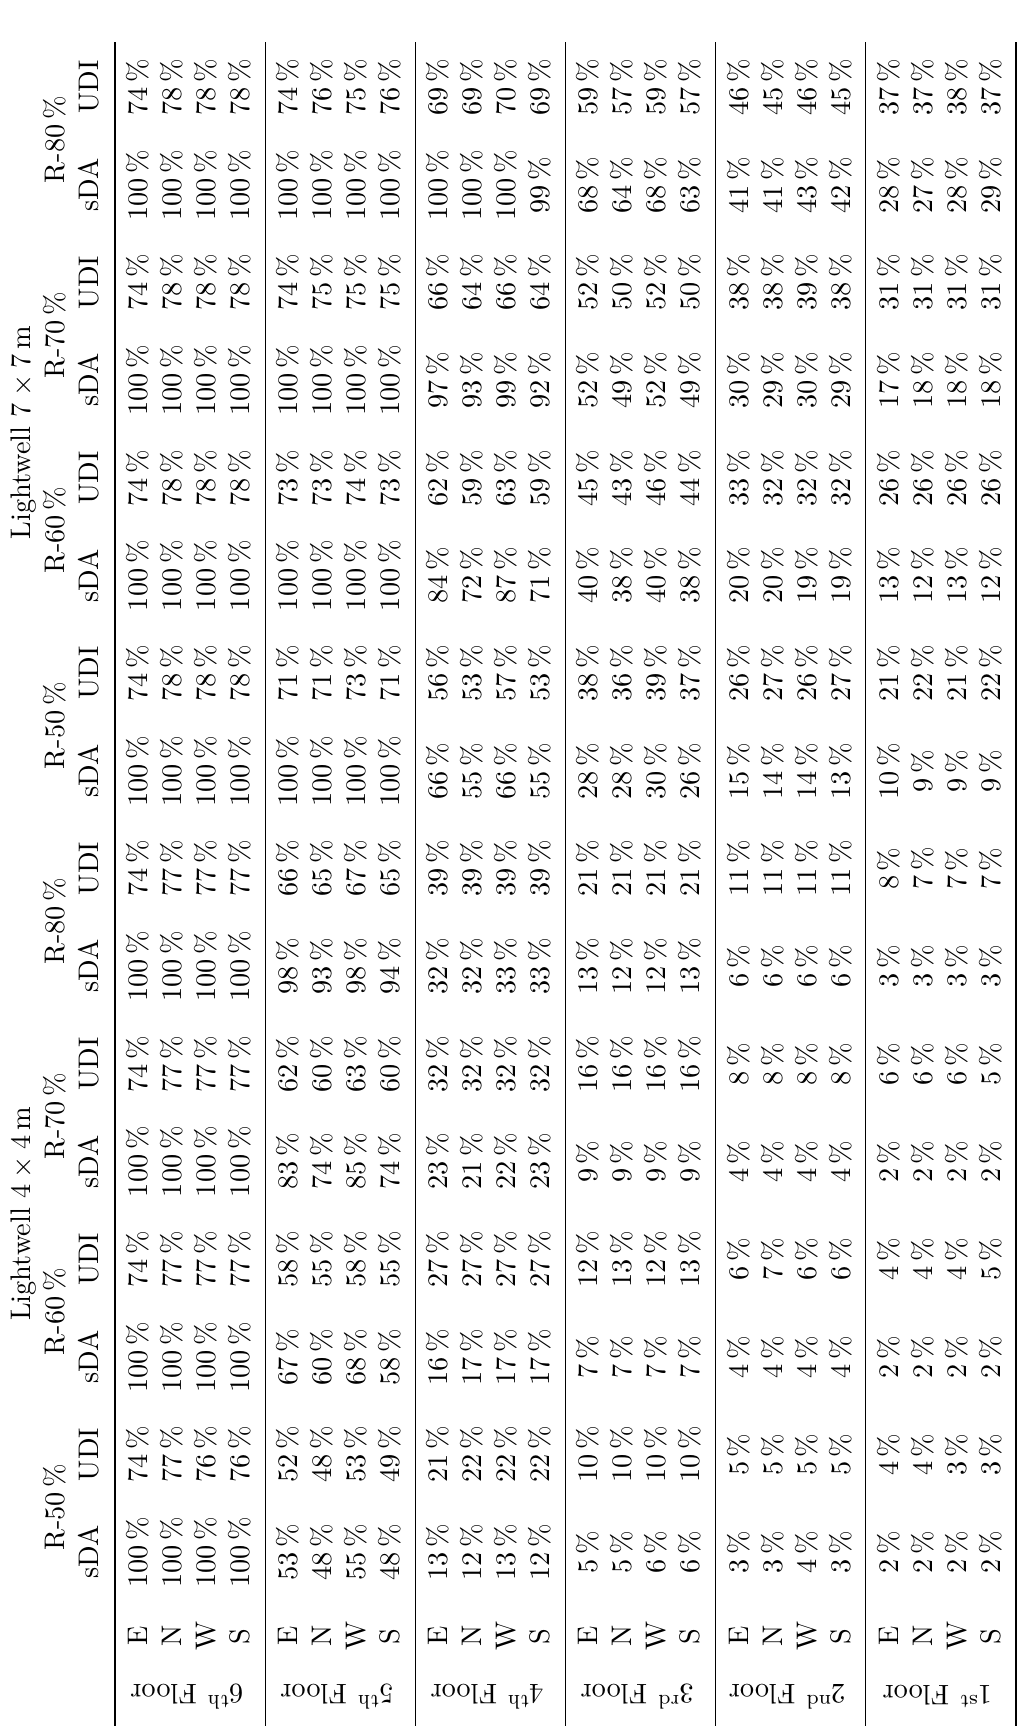
Table 1. Comparison between the metrics values under different reflectance levels at Macapá